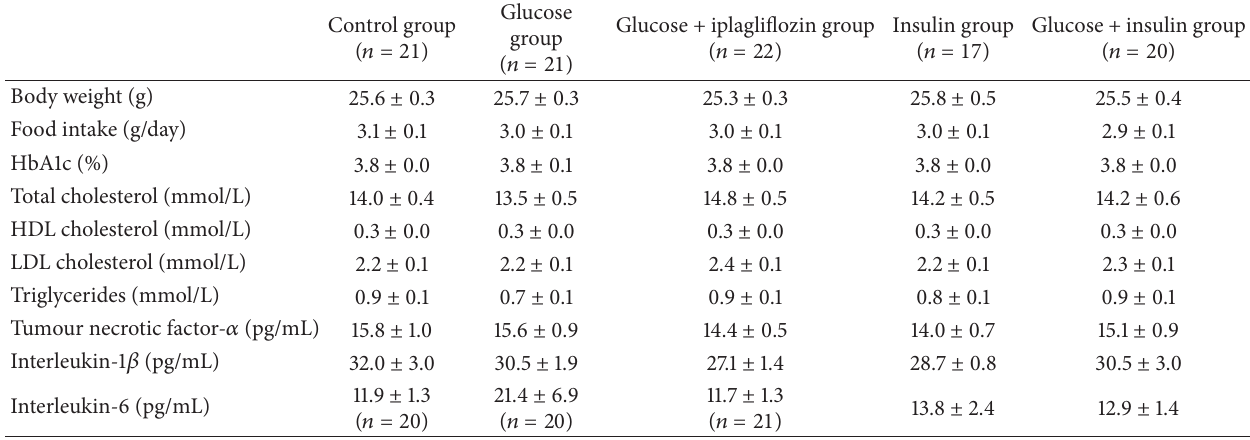
Table 1: Body weight, food intake, and laboratory data for each group after 15 weeks’ administration.